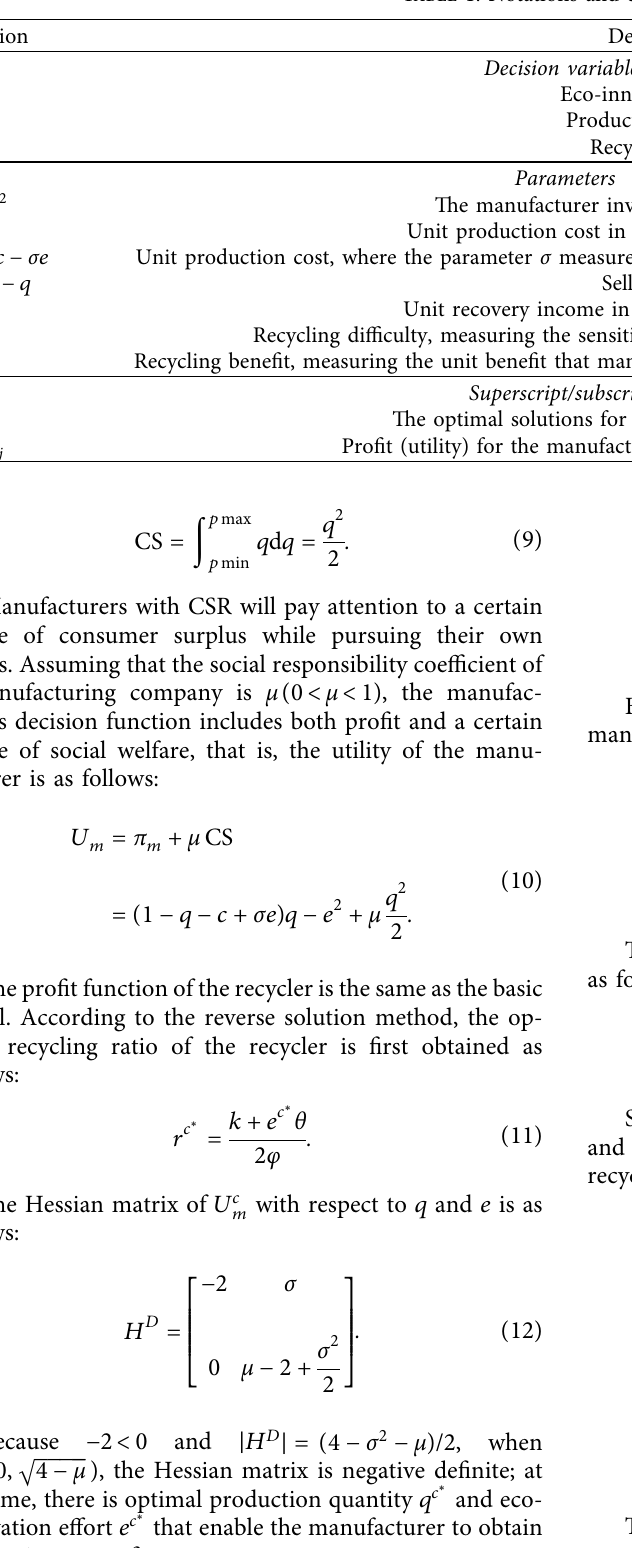
Table 1: Notations and